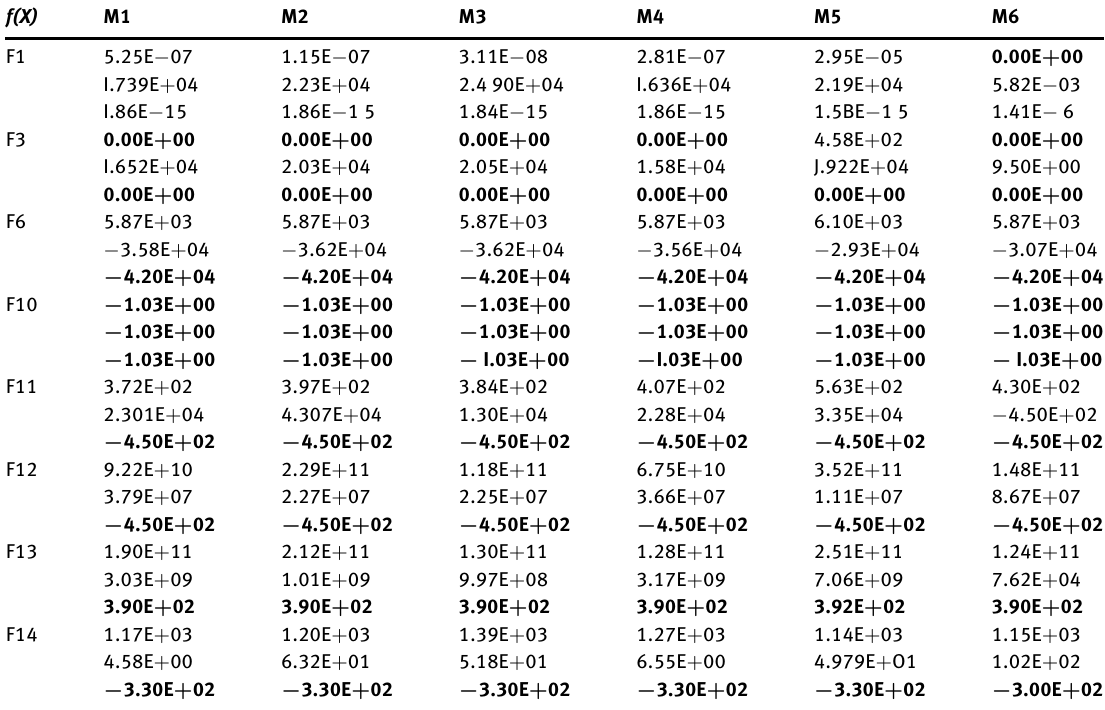
Table 7: Simulation Results of CS, HS, and ABC Using Different Functions and Mutations. f(X) M1 M2